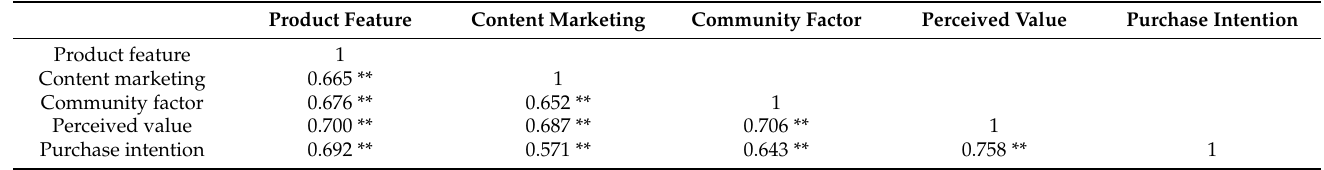
Table 7. Analysis result of the correlation.